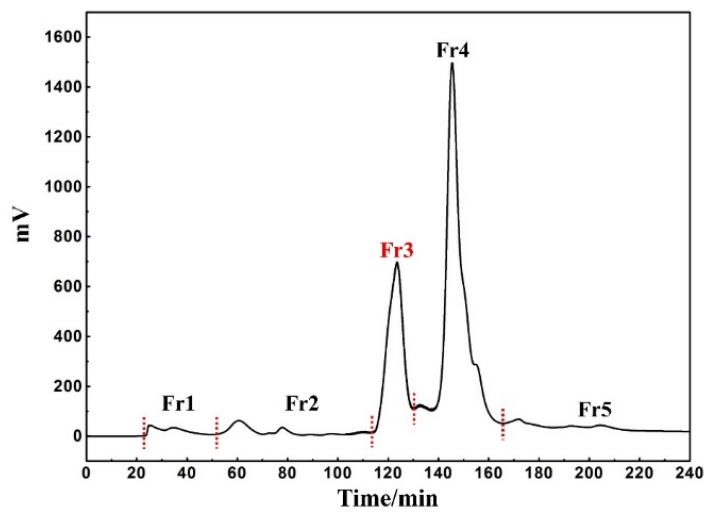
Figure 1. Chromatogram of rape pollen extract pretreatment with MCI-MPLC.